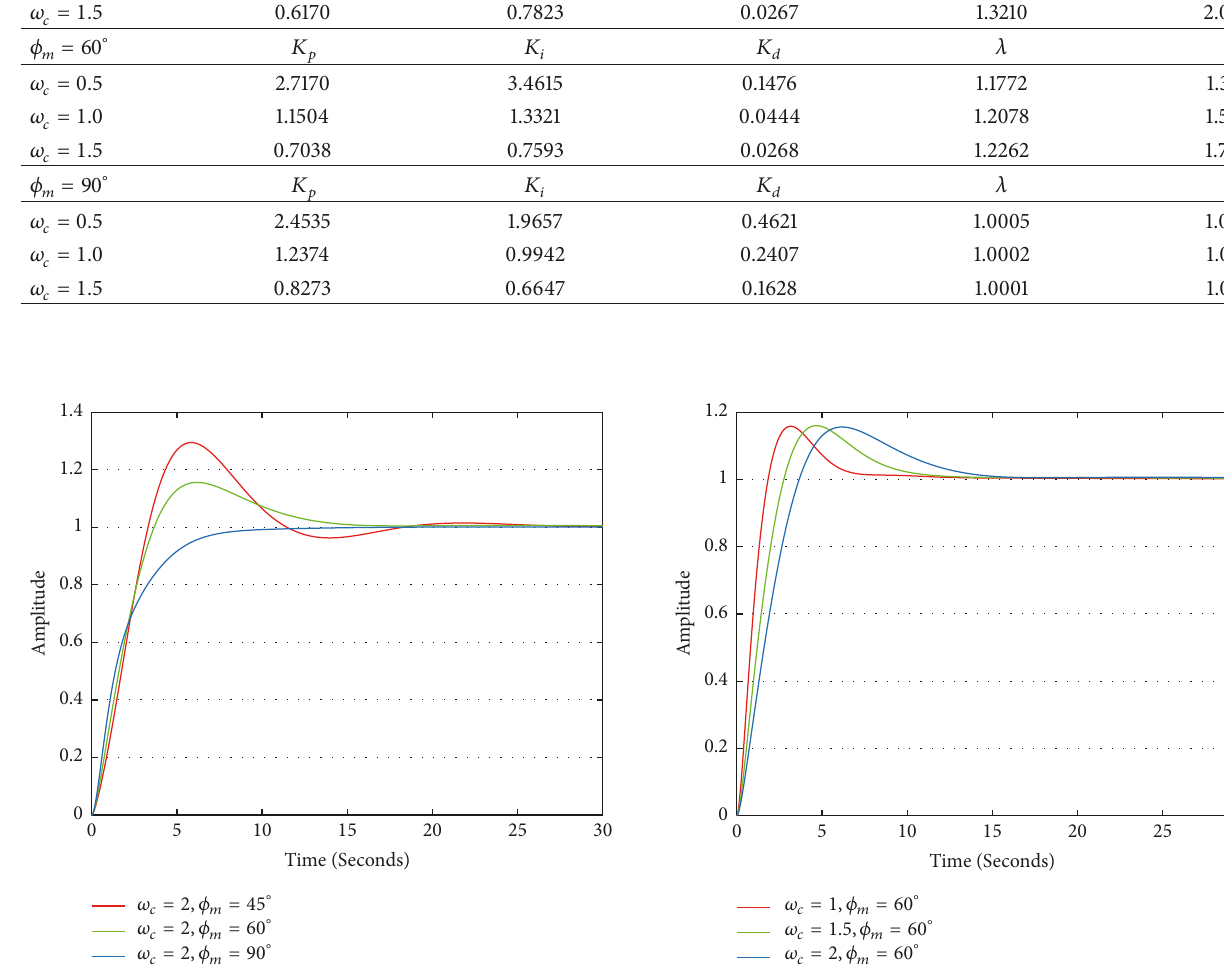
Figure 20: Step response of 𝑃 3 (𝑠) with the same 𝜔 𝑐 . Figure 21: Step response of 𝑃 3 (𝑠) with the same 𝜙 𝑚